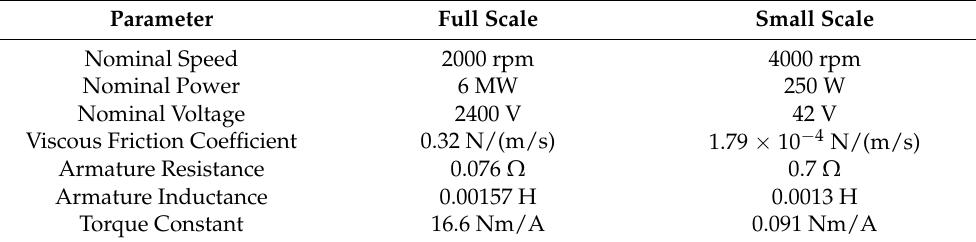
Table 2. DC machine parameters for full- and small-scale